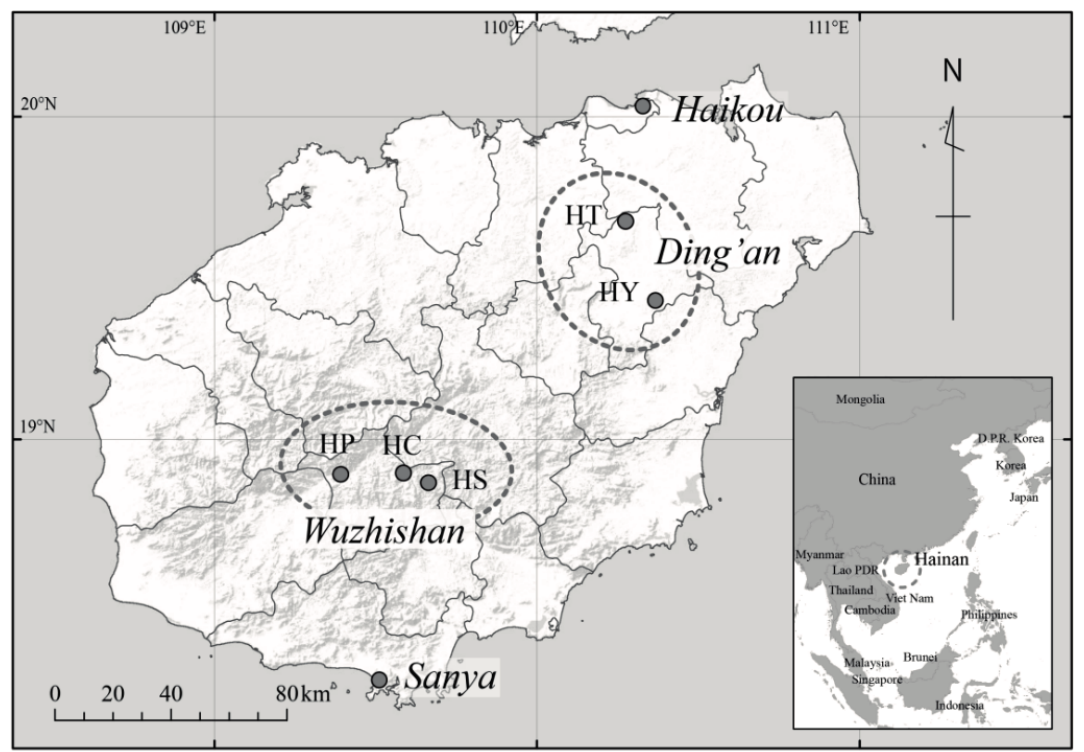
Figure 1. Map of Hainan